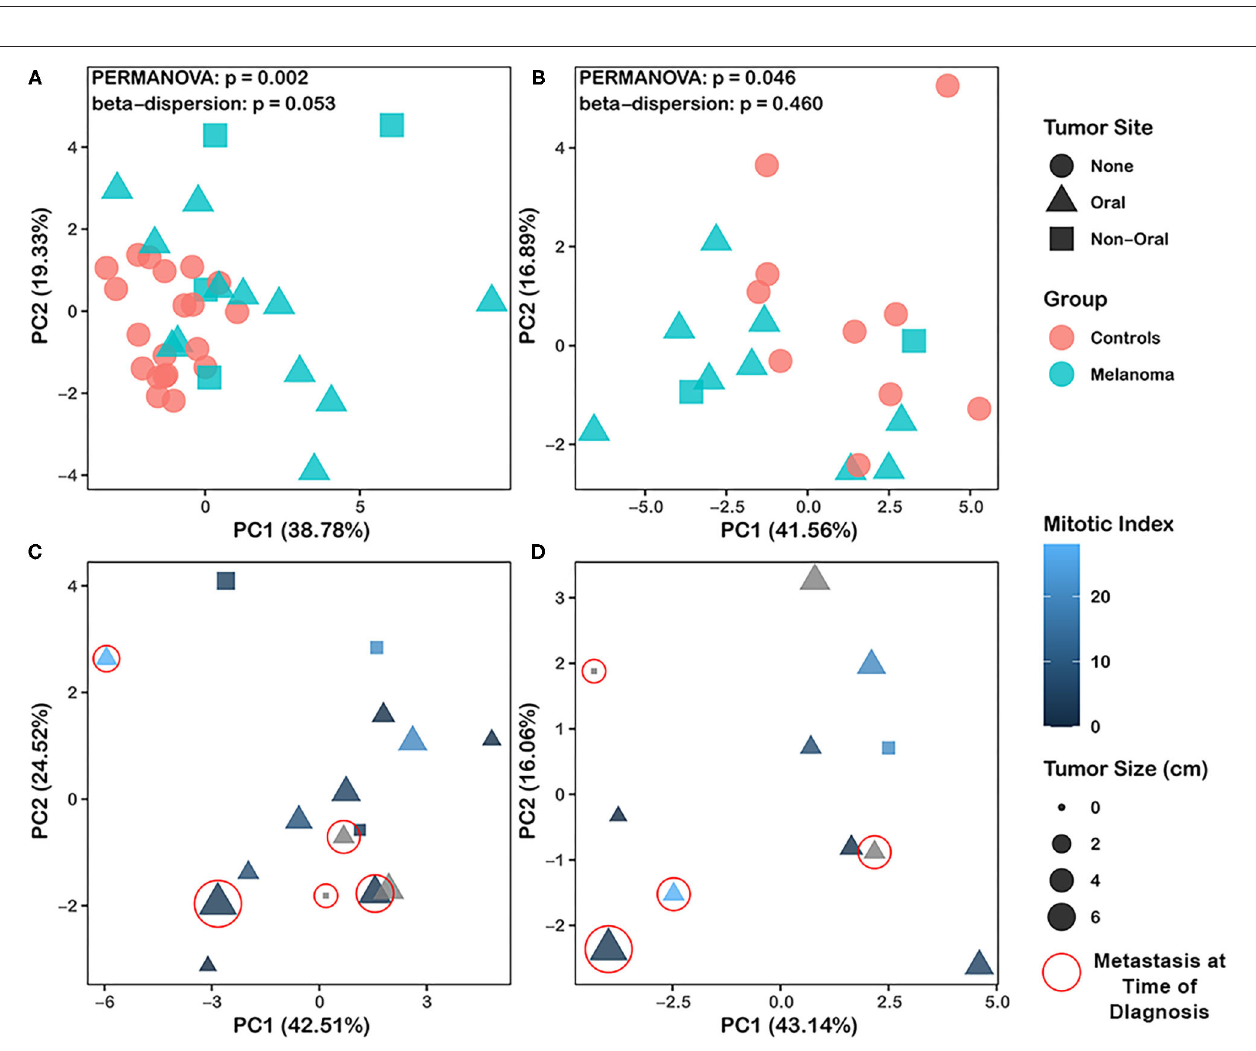
FIGURE 1 | stain and gating on CD3 + cells as the parental gate for T cell subsets. (B) Scatter plots showing interrogation of CD4 + T cells are representative for gating of specific populations for all T cell subsets. Regulatory CD4 + T cells include FoxP3 + (h) and CD25 + FoxP3 + (e). CD25 + FoxP3- cells (f) represent an activated T cell subset and CD25-FoxP3- cells (g) are designated as a quiescent T cell subset. Interrogation of FoxP3 + cells for Ki67 reveals the gating strategy for Ki67 + cells for all subsets. Gating strategies for CD25 and Granzyme B are shown for both CD4-CD8- and CD8 + T cells. (C) Representative scatter plots show interferon- γ staining and gating for CD4 + , CD8 + and CD4-CD8- T cell subsets with or without stimulation with Con-A.